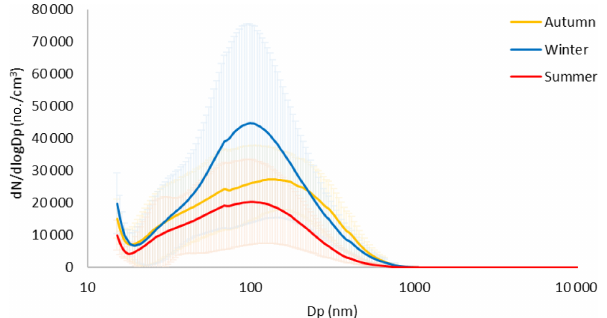
Figure 6. Seasonal average (line) and standard deviation (shadow) of the particle number size